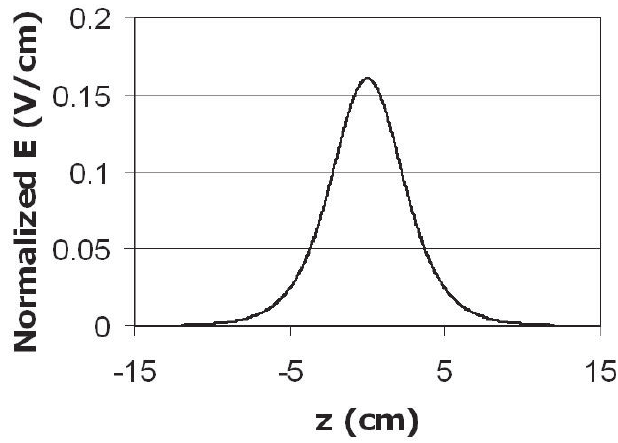
FIG. 10. The longitudinal electric field for the IBM gap model [Eq. (A8)] with b (cid:5) g (cid:5) 4 cm